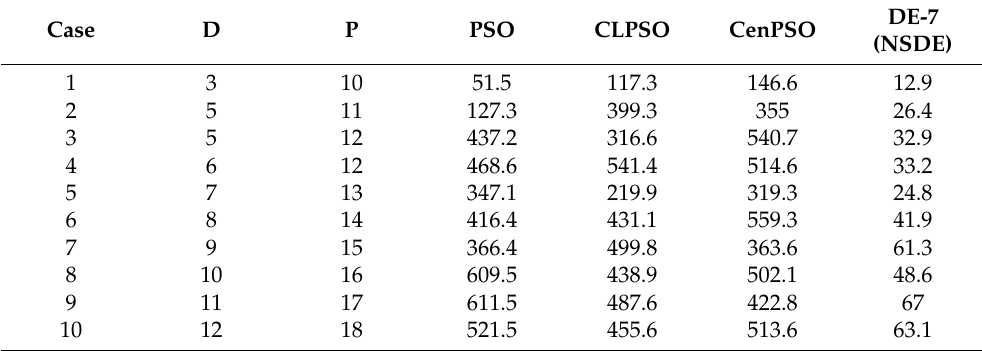
Table 20. Average number of generations for discrete PSO, CLPSO, CenPSO, and DE-7 (NSDE) algorithms with NP = 50; r D = r P = 0.1.